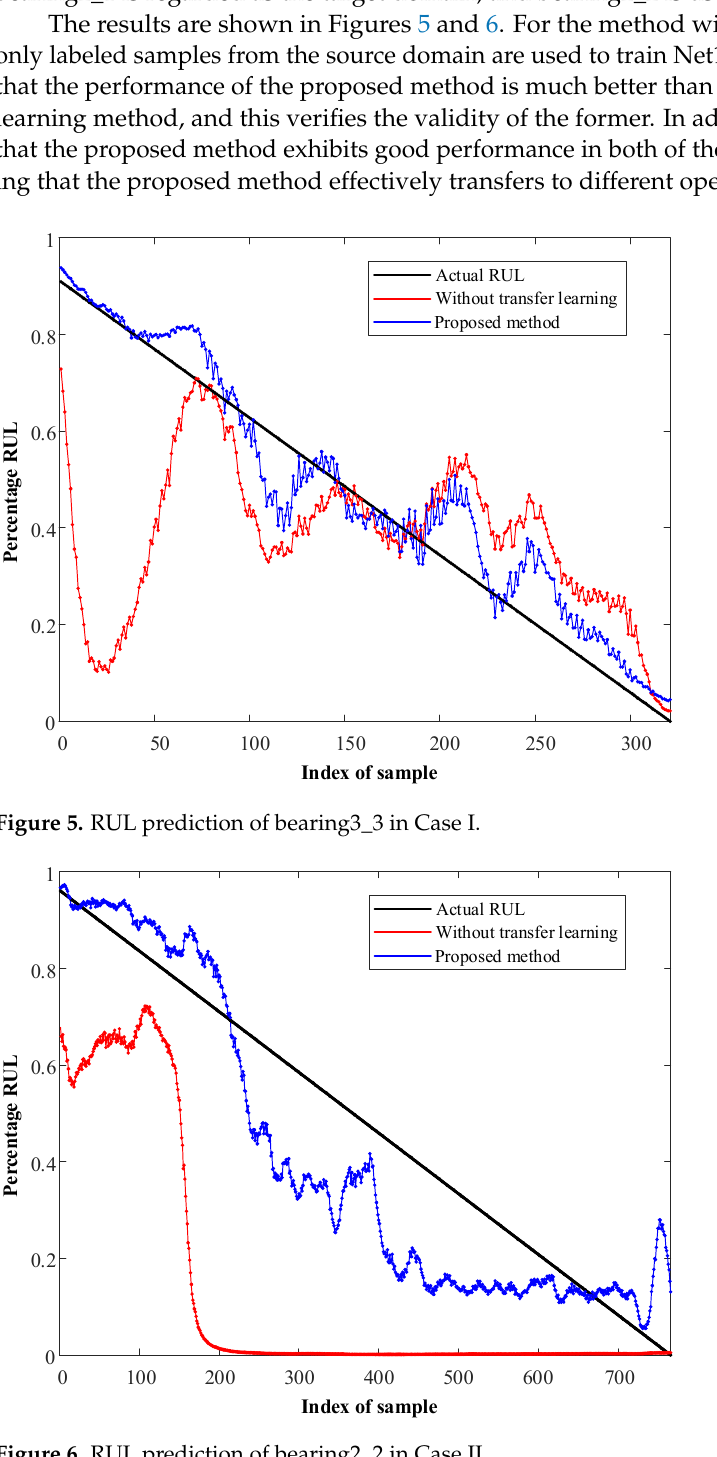
Figure 6 .RUL prediction of bearing2_2 in Case II.